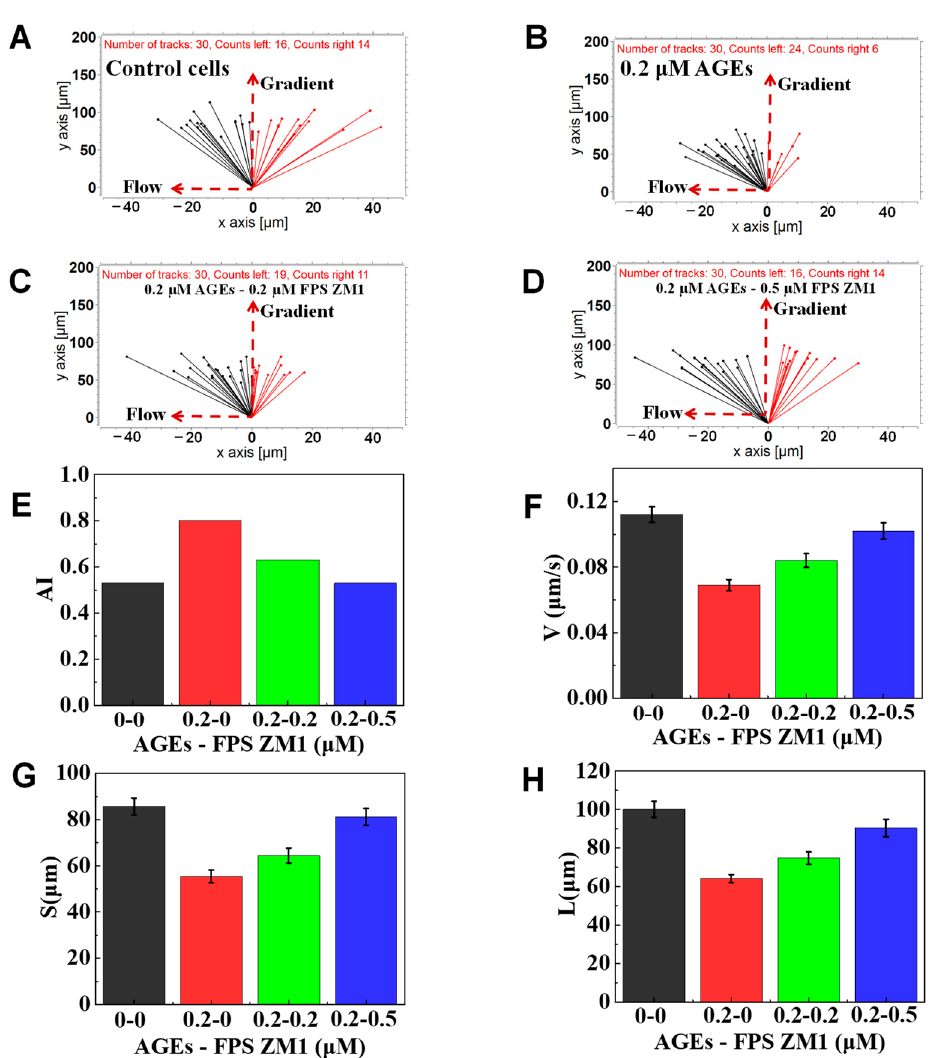
Figure 8. Chemotaxis of AGEs, FPS ZM1, and their mixture-treated test cells in 100 nM of fMLP gradient. ( A ) The connecting line between the initial position and the end position of normal cells. ( B ) The connecting line between the initial and end position of cells pretreated with 0.2 μ M AGEs and 0 μ M FPS ZM1. ( C ) The connecting line between the initial and end position of cells pretreated with 0.2 μ M AGEs and 0.2 μ M FPS ZM1. ( D ) The connecting line between the initial and end position of cells pretreated with 0.2 μ M AGEs and 0.5 μ M FPS ZM1 pretreated cells. ( E – H ) Comparison of quantitative cell migration parameters including drifting index (AI), cell velocity (V), the displacement along the gradient (S), and the whole movement distance (L).